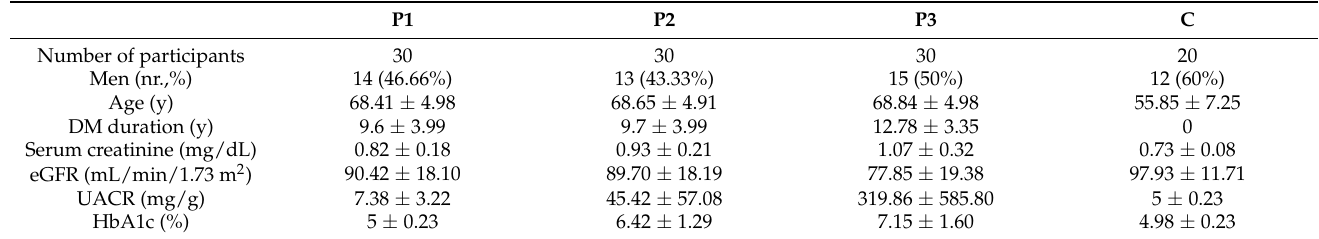
Table 2. Demographic and clinical